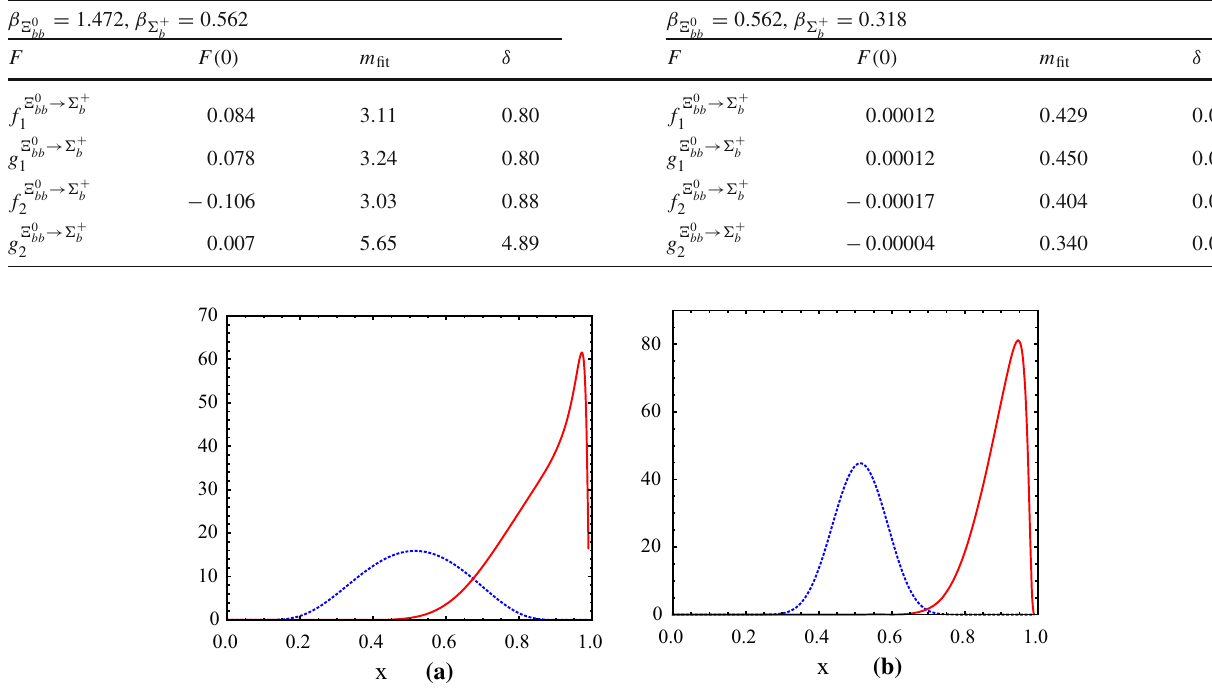
→ (cid:6) + process. For b bb = 0 . 562 GeV have been (cid:6) + b = 0 . 562 GeV and bb